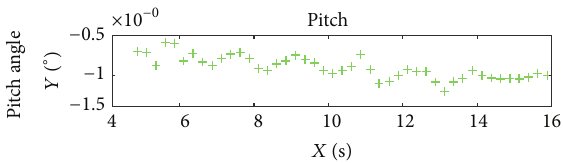
Figure 4: The attitude angle (Pitch) curve in 10 seconds.